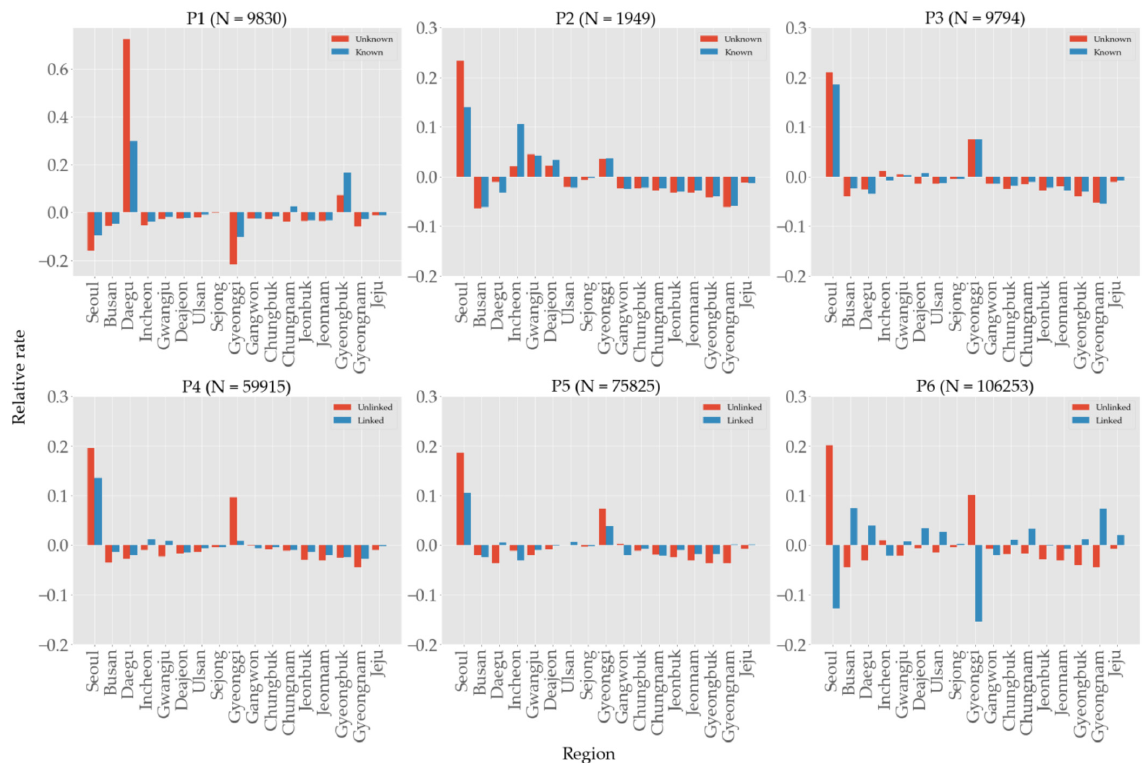
Figure 9. Regional shares of confirmed cases relative to population size. See Figure S2 for confirmed cases per 1000